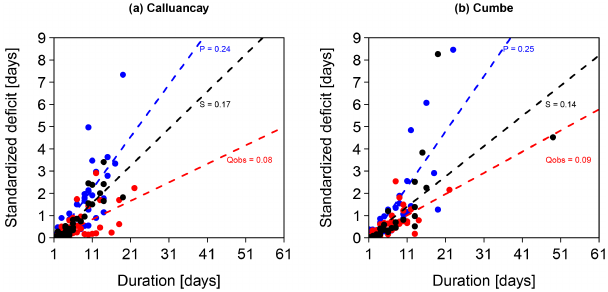
Figure 5. Standardized deficit for the drought periods in (a) Cal- luancay and (b) Cumbe: precipitation ( P , in blue), simulated soil water storage ( S , in black), and observed stream discharge ( Q , in